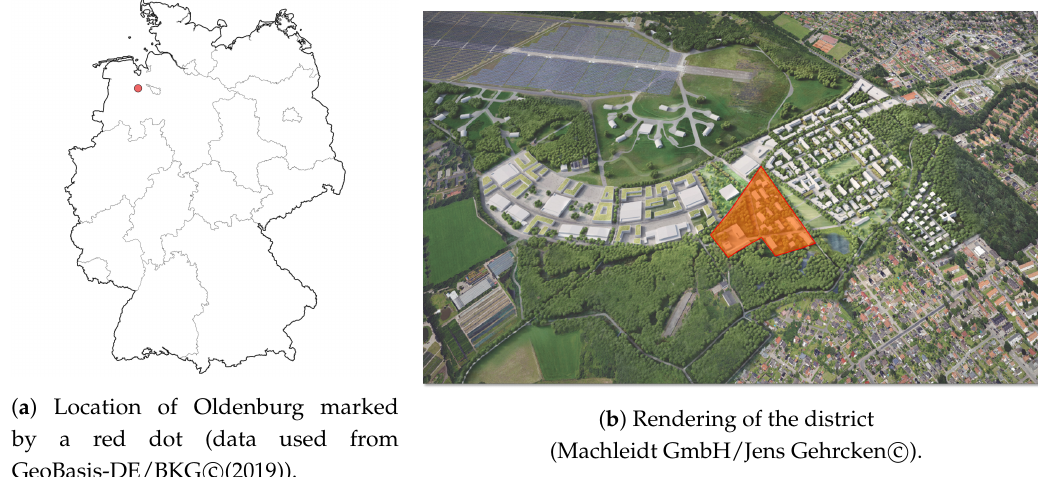
Figure 2. Geographical location of the project